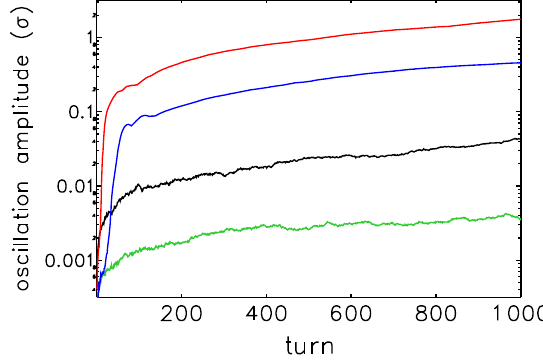
FIG. 7. Ion instability amplitude (in units of vertical beam size) for 324 bunches, 200 mA, 1000 Ah conditioning. Black: 20% NEG, flat; red: 20% NEG, round; green: 50% NEG, flat; blue: 50% NEG, round.